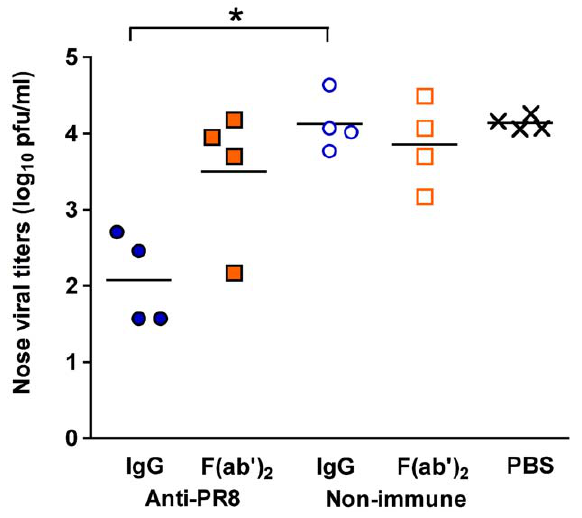
Figure 3. Virus load reduction is not enhanced by a second dosing with Ab. BALB/c mice were given 500 pfu of PR8 virus in 10 m l by the intranasal route to establish a localised URT infection. One and 3 days post-infection, mice were treated with 200 m g of each Ab preparation or PBS via the URT route. Five days post-infection, mice were killed and nasal turbinates were collected in 1 mL media. Viral titers were determined by plaque assay on MDCK cell monolayers. The experiment was performed once with 4 mice per group, the organs assayed in quadruplicate and titers averaged to provide a value for that animal. Each symbol represents an individual mouse and the line represents the mean of each group. Brackets with an asterisk indicate a statistically significant difference between the indicated groups.